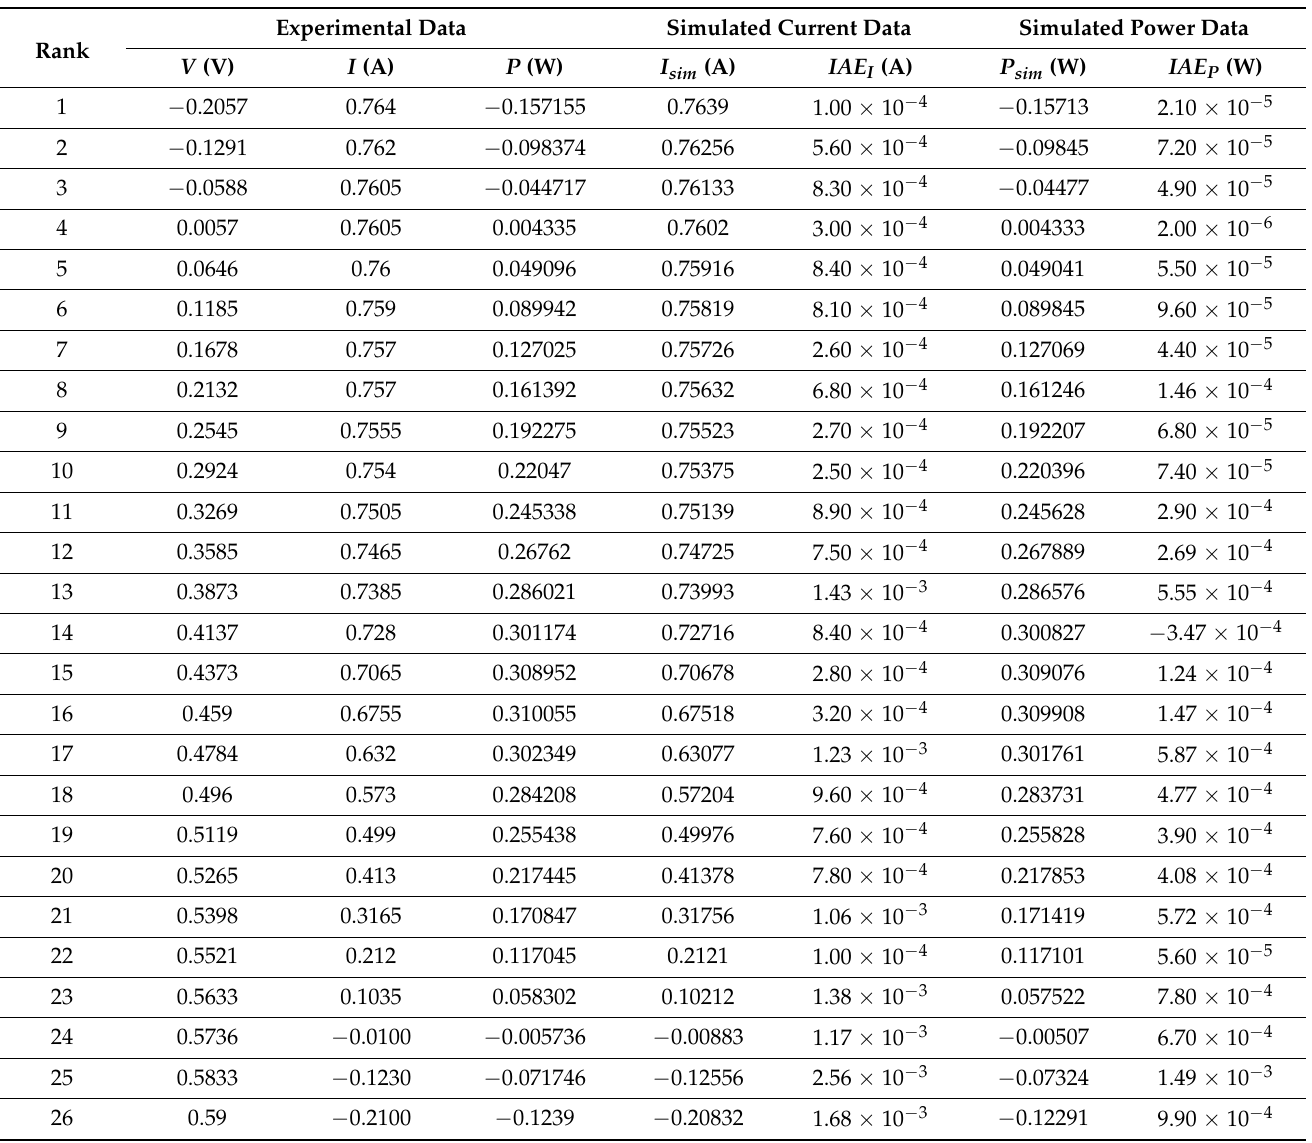
Table 11. Experimental and simulated data of voltages, currents, and power and the absolute errors values using MECPO for